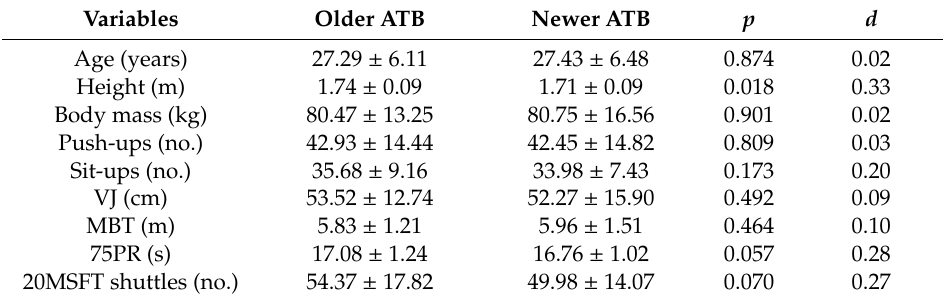
Table 1. Descriptive and fitness testing data from recruits hired under an older ATB ( n = 526), versus one class hired under the LEA’s newer ATB ( n = 58).